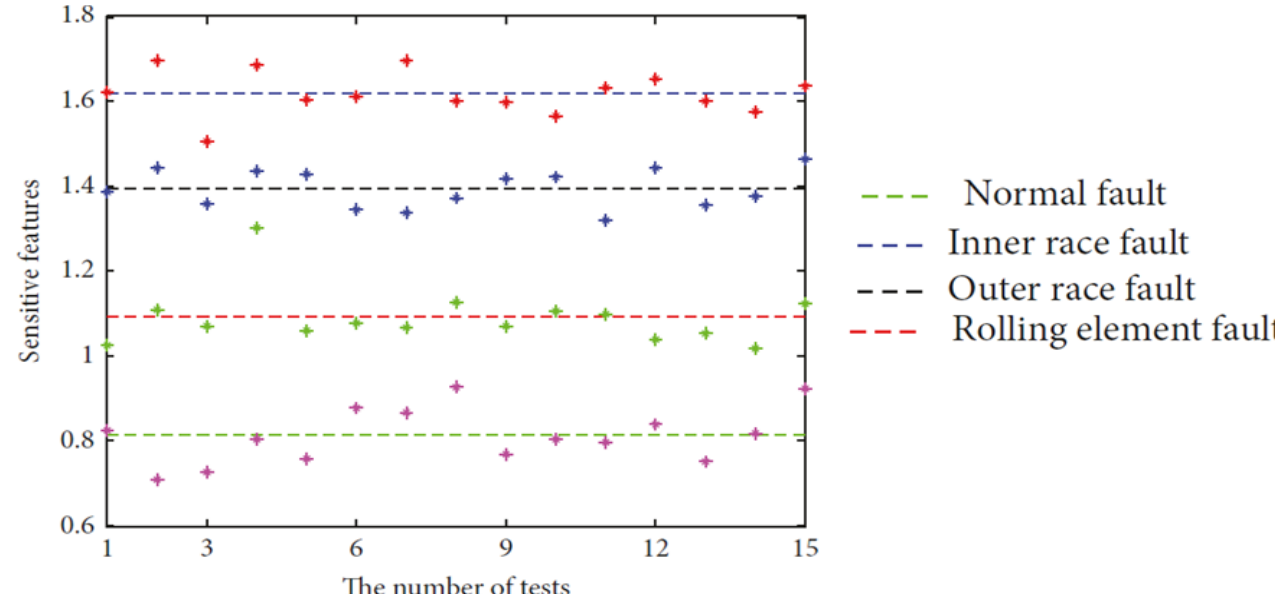
Figure 38. Test classification results for the diagnosis of rolling bearing element faults in rotating machines [100].